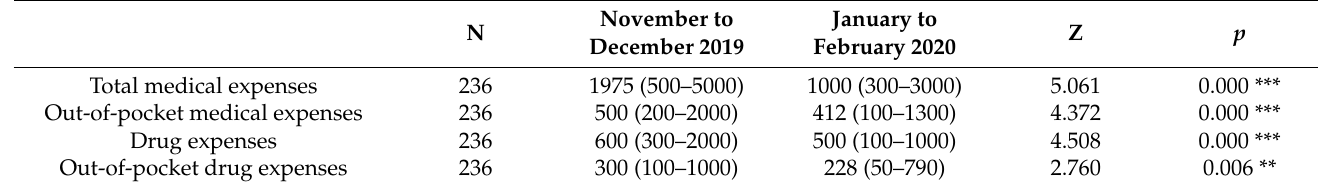
Figure 2. Frequency of outpatient visits in chronic diseases respondents before and during the COVID-19 pandemic. Table 3. Outpatient medical expenses for respondents with chronic diseases (RMB).